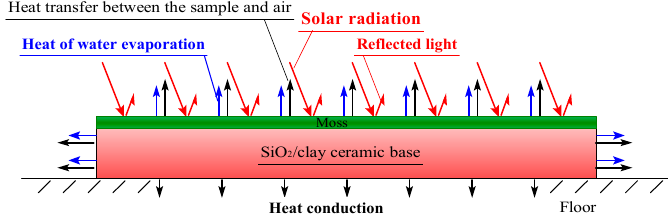
Figure 8. Schematic diagram of heat balance on the moss sample.